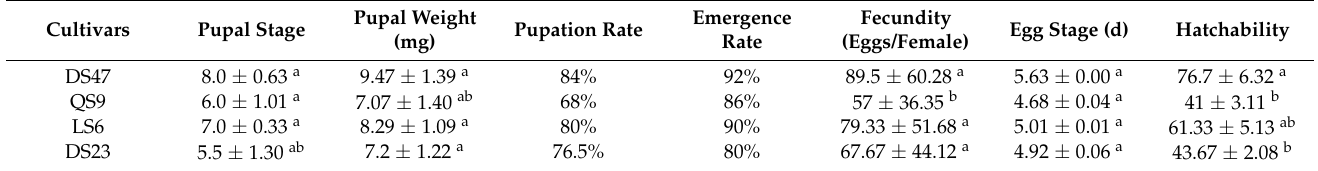
Table 2. Reproduction parameters of PTM feeding on different potato varieties.